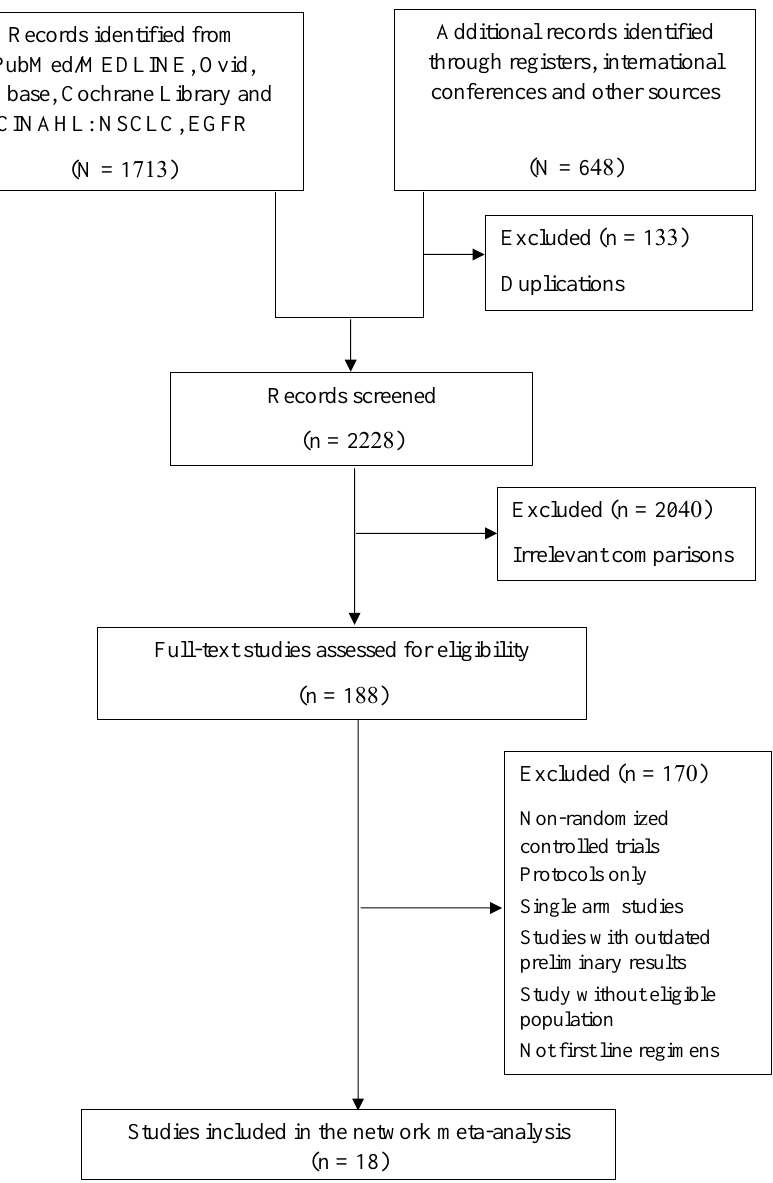
Figure 1. Study flowchart presenting the results of the systematic